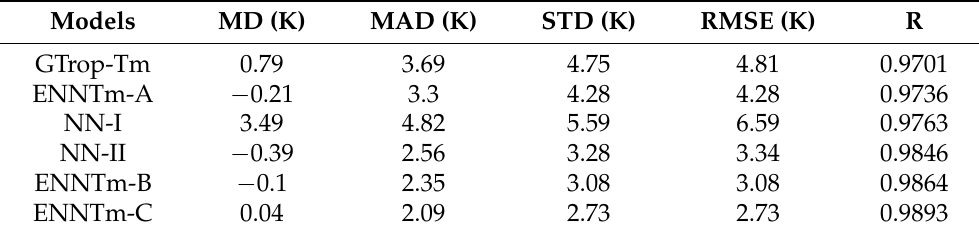
Table 4. The accuracies of different models validated by data from the Earth’s surface to a 10 km altitude during 2017 and